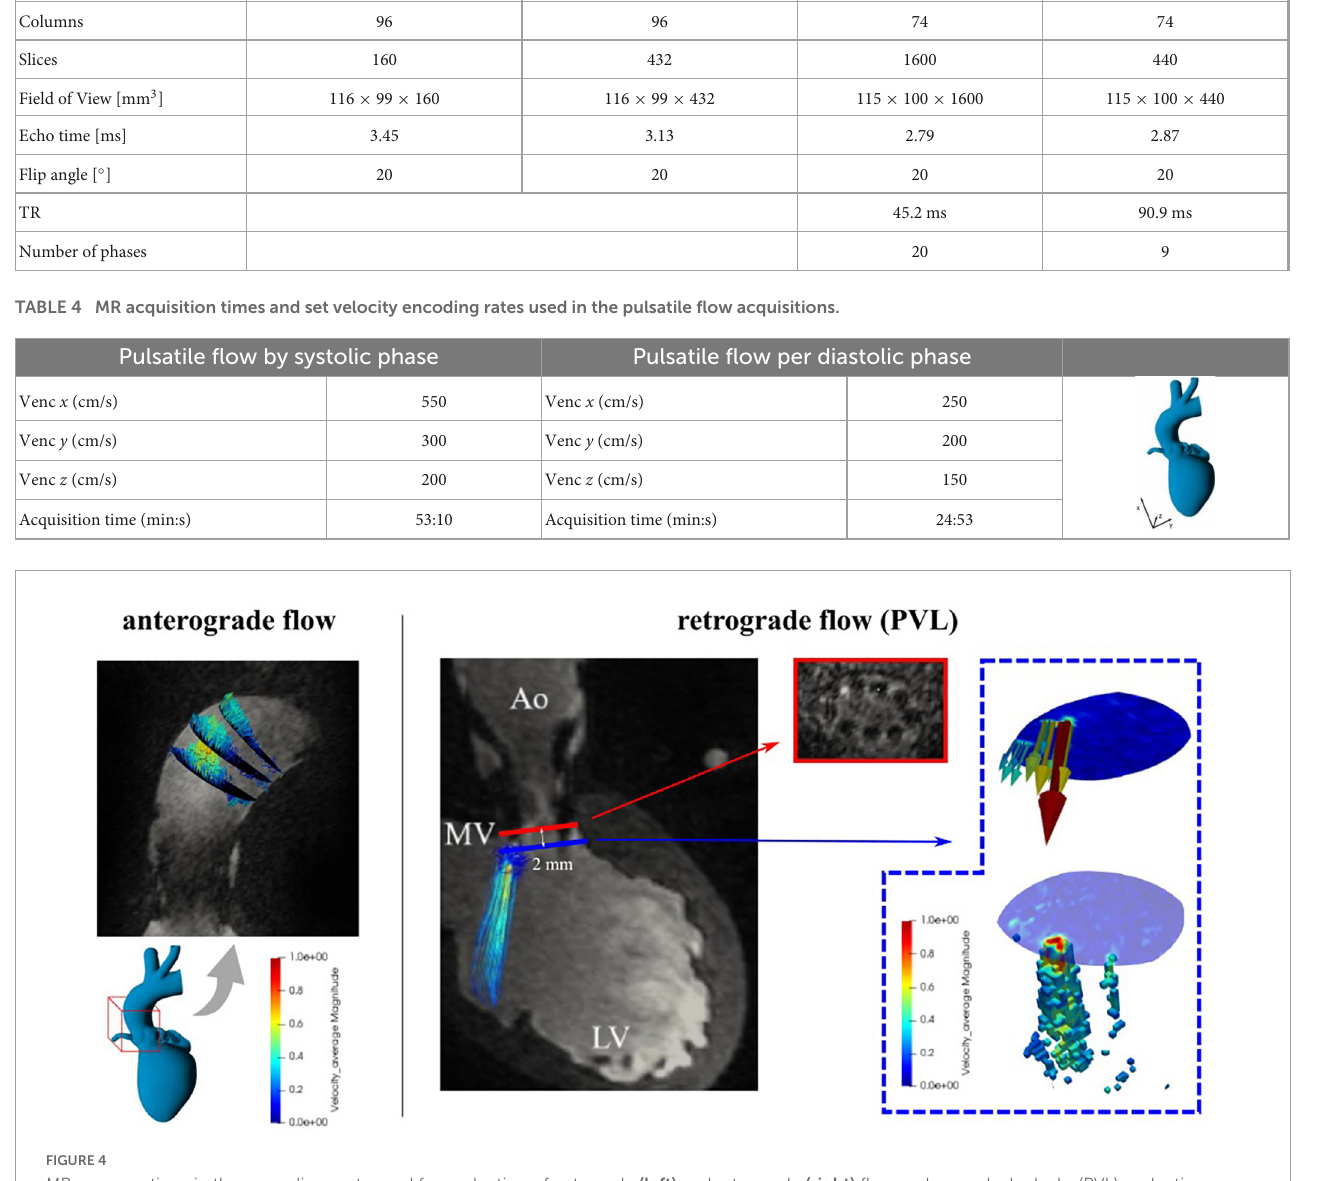
FIGURE4 MR cross sections in the ascending aorta used for evaluation of antegrade (left) and retrograde (right) flow and paravalvular leaks (PVL) evaluation.